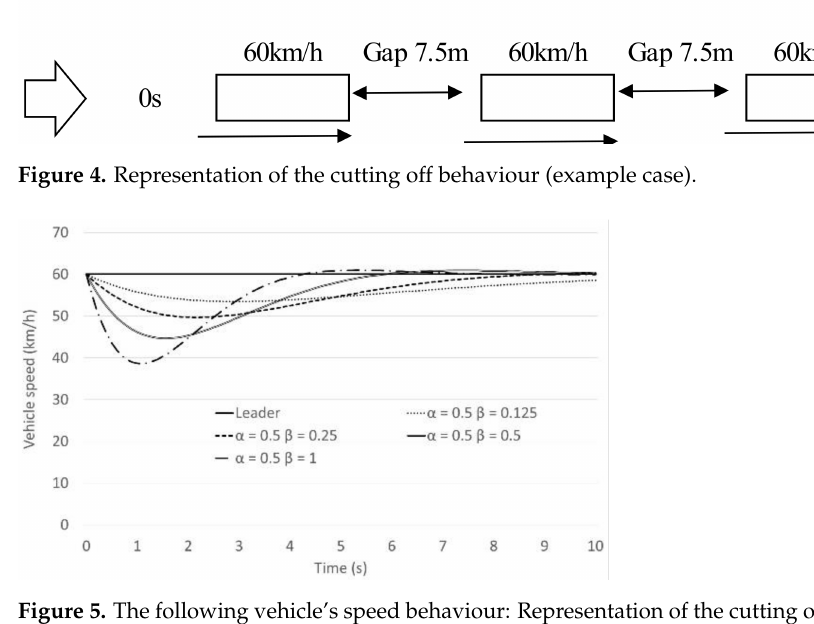
Figure 5. The following vehicle’s speed behaviour: Representation of the cutting off behaviour Speed ( α is fixed).